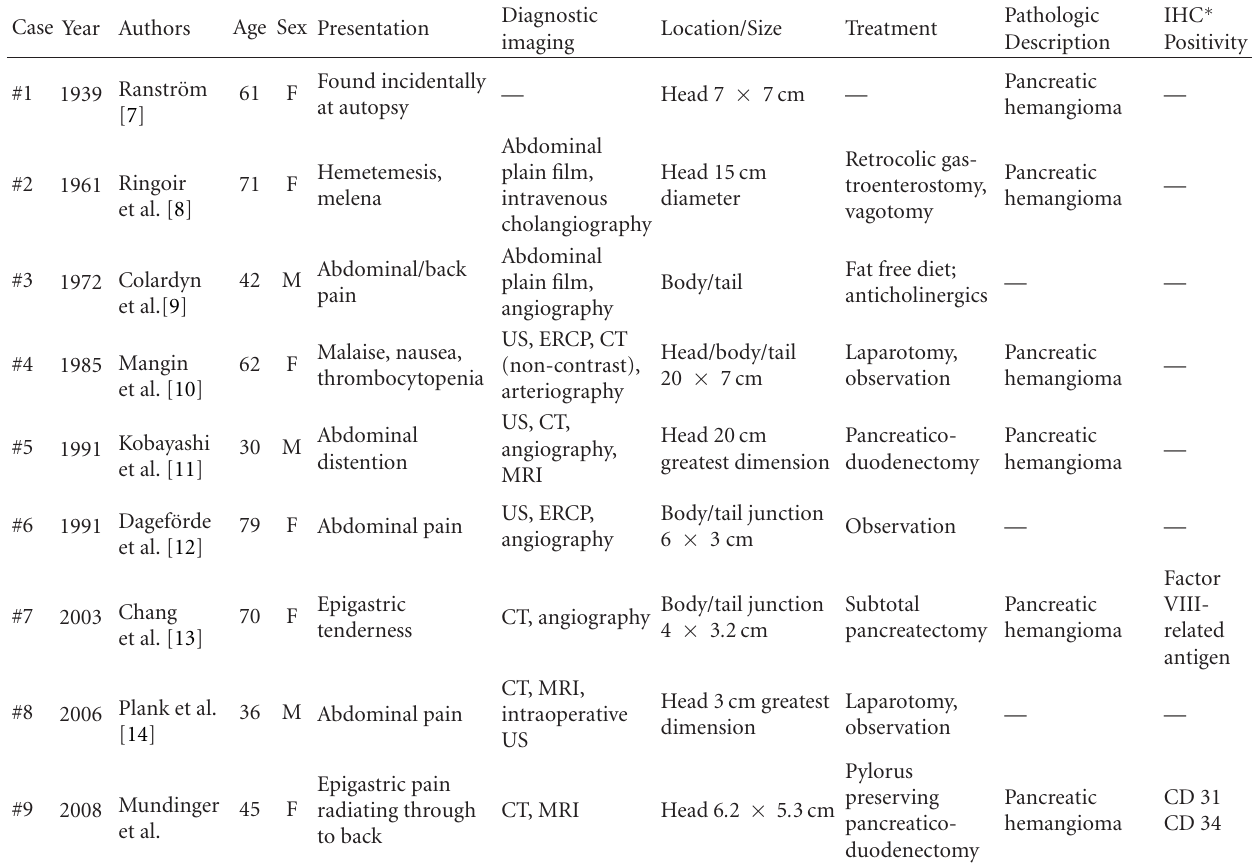
Table 1: Adult pancreatic hemangiomas reported in literature since